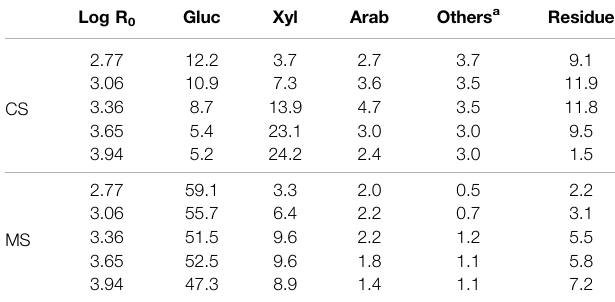
TABLE 1 | List of pretreatment conditions and corresponding severity factors. Temperature [ ° C]